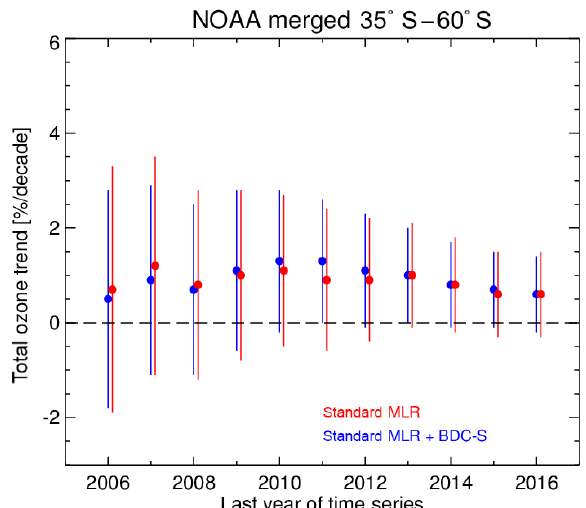
Figure 5. Same as Fig. 4 but for SH extratropics (35 ◦ S–60 ◦